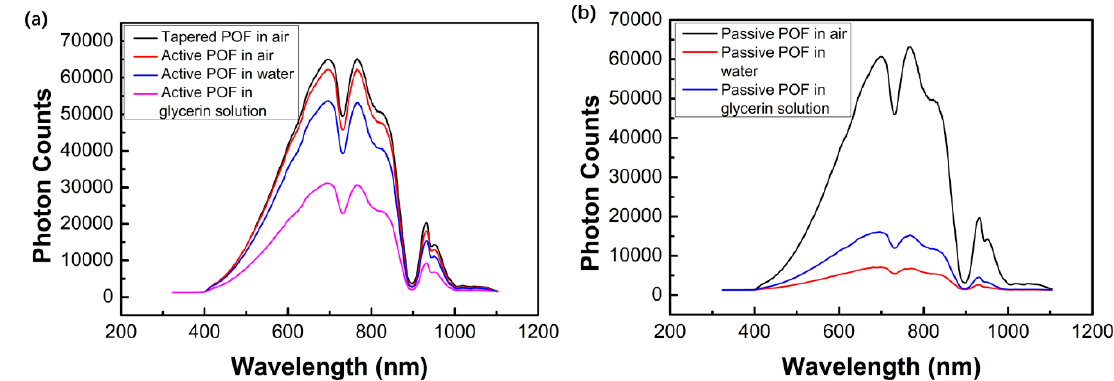
Figure 2. The transmission spectrum of the active ( a ) and passive ( b ) fiber with the diameters of 100 µ m and 200 μm, respectively .